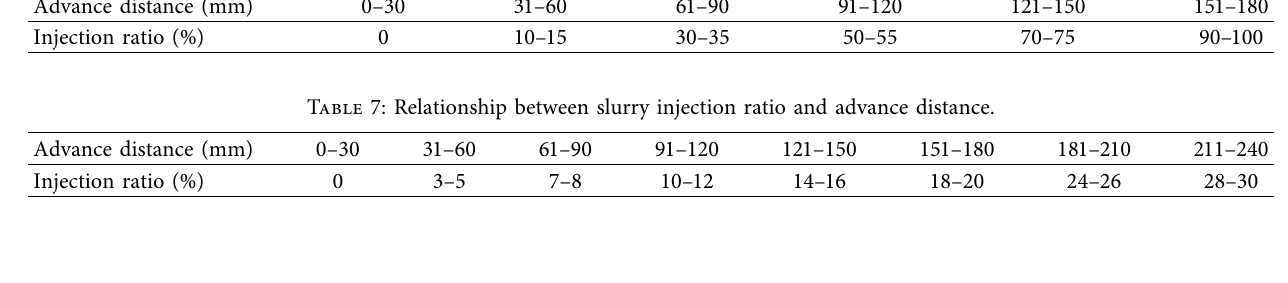
Table 8: Driving parameters of shield cutter